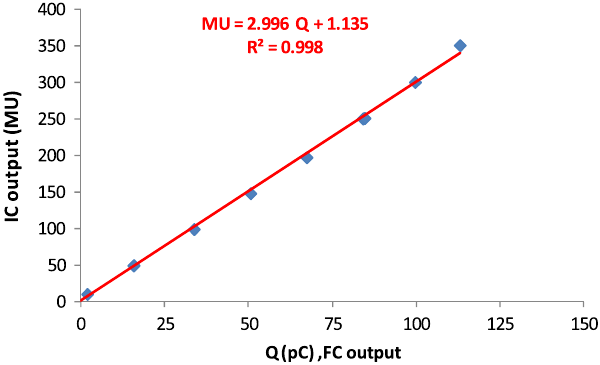
FIG. 22. IC B output in MU versus the charge measured by the FC. The red line is a linear fit, with parameters quoted in the plot text.